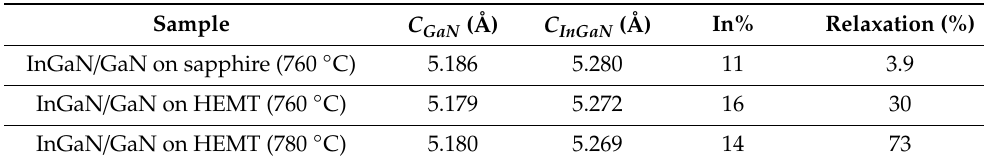
Table 1. The out-of-plane lattice constant c of GaN, InGaN, and relaxation degree in InGaN layer of the three samples.